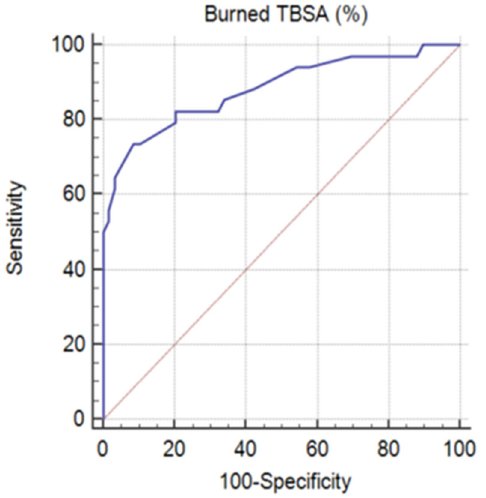
Figure 4. ROC curve for the TBSA (%) variable (TBSA—total body surface